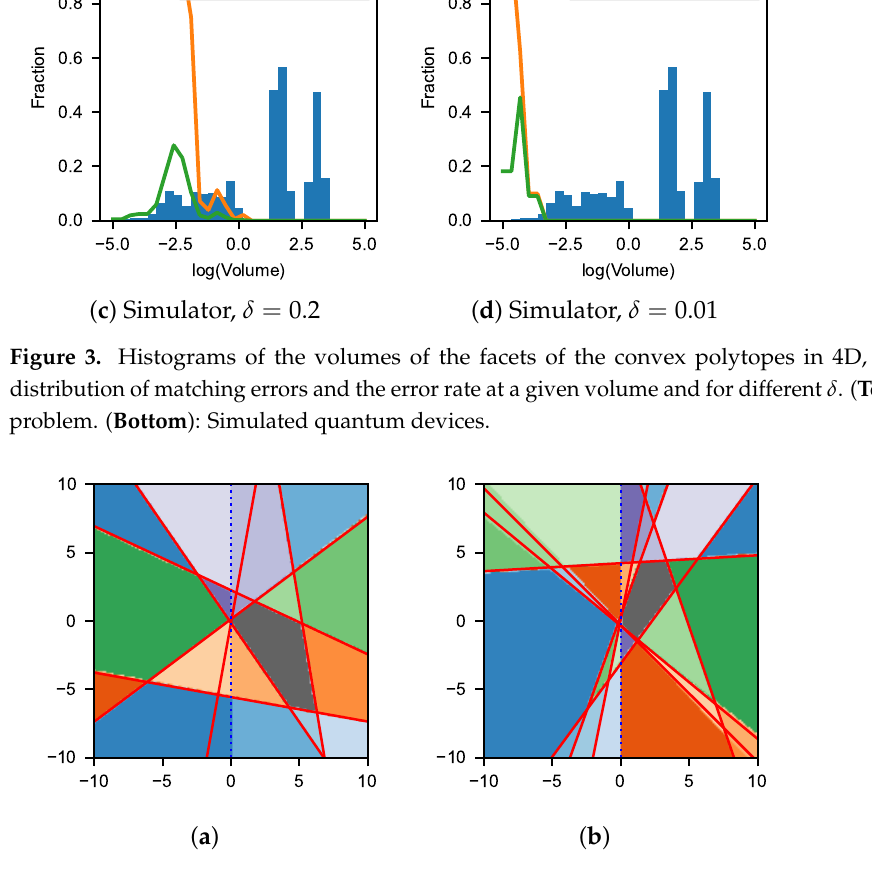
Figure 4. Examples of typical errors of the algorithm with δ = 0.2 on the simulated device. Shown are two different 2D cuts through the same 4D volume. Cuts are chosen such that a wrongly estimated facet appears as a vertical line through the origin (blue dashed line). Red lines represent the constraints of estimated facets that intersect with the image plane. For better visibility of errors, areas are colored based on a partitioning of the plane by the ground truth constraints. Each area depicts a region where a certain set of ground truth constraint agree on the point belonging to the convex polytope. The true area of the polytope where all constraints agree is depicted by dark grey. An estimated constraint is correct if it correctly separates the areas. Units are displayed relative to the chosen origin. ( a ): Error in estimating the correct angle of a small facet. The facet is found but significantly tilted to the right in comparison to the dotted line, which can be seen as it passes through the light purple area on top. ( b ): Missing edge due to small facet